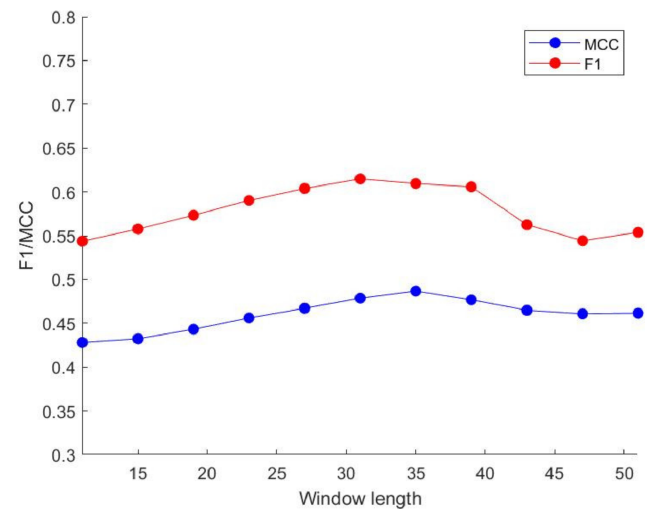
Figure 6. Different window size performance in